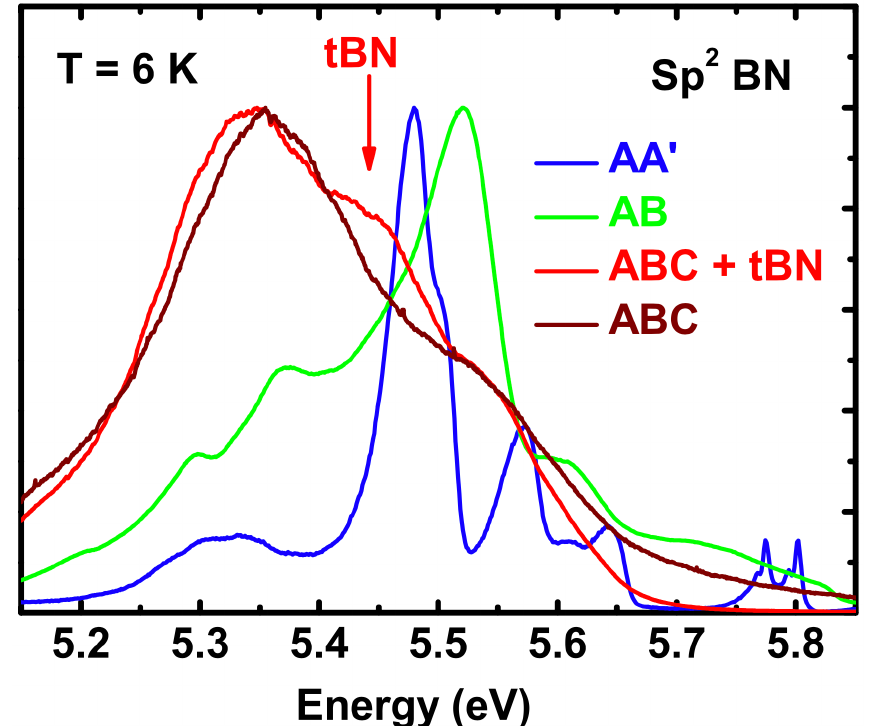
Figure 11. Photoluminescence spectra recorded on two rBN-rich epilayers (red and wine) in comparison with those typical AA’ (blue) and AB (green) stackings. Note the signature of tBN. See reference [72] for more